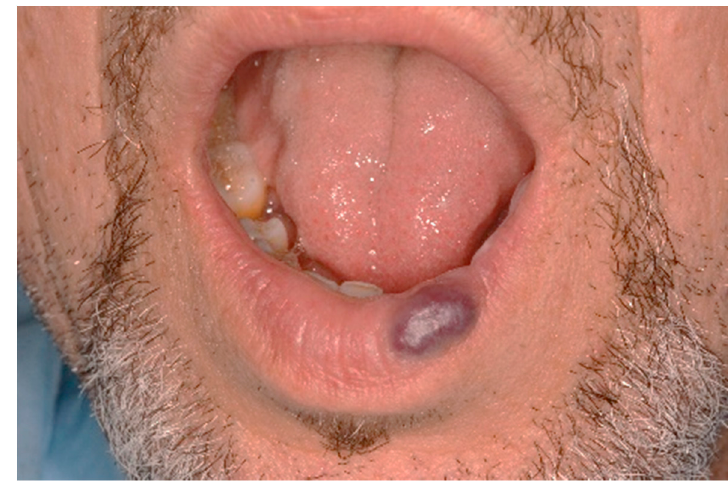
Figure 7. Clinical aspect of the lesion VM on the lower lip.